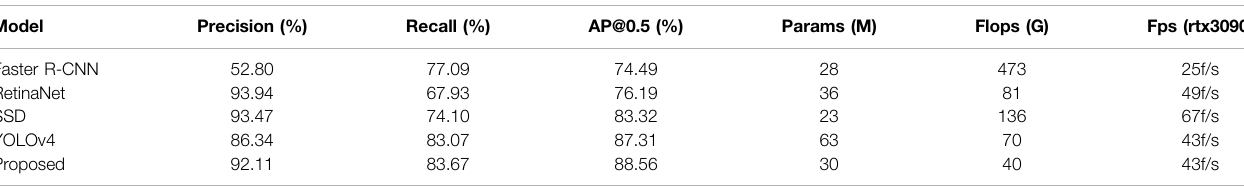
TABLE 2 | Test results of the different detection